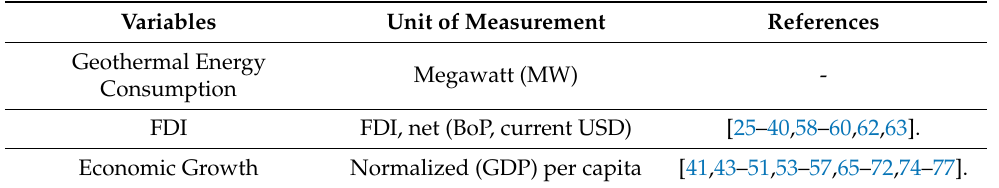
Table 1. Information on the dataset of the